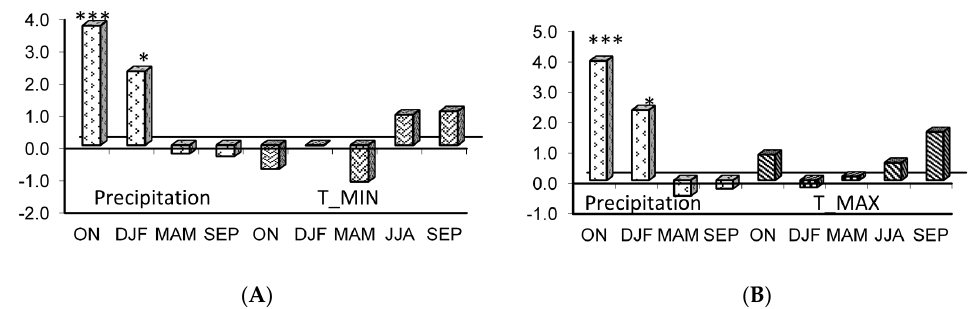
Figure 4. Response function analysis of the residual tree ring chronology of Quercus suber in the young stand (YS) to monthly climatic data from October ( t − 1) to September ( t ) for the period 1974–2002: ( A ) for the joint effect (P-TMIN) of precipitation P and minimum temperature (TMIN) and ( B ) for the joint effect (P-TMAX) of precipitation P and maximum temperature (TMAX). The number of stars indicates significance at 95%, 99%, and 99.99% levels, respectively. (MRC/SC = 99.99% and MRV/SV = 95%).